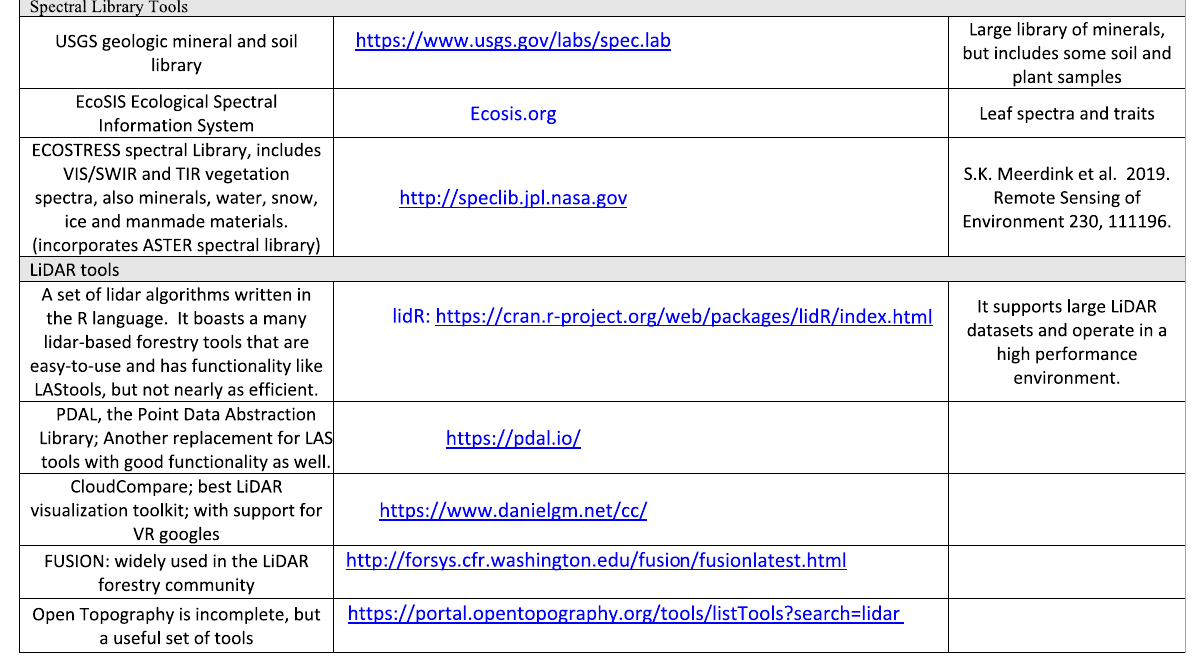
Table 7 Examples of Open Source Programs for Analyzing Satellite Data